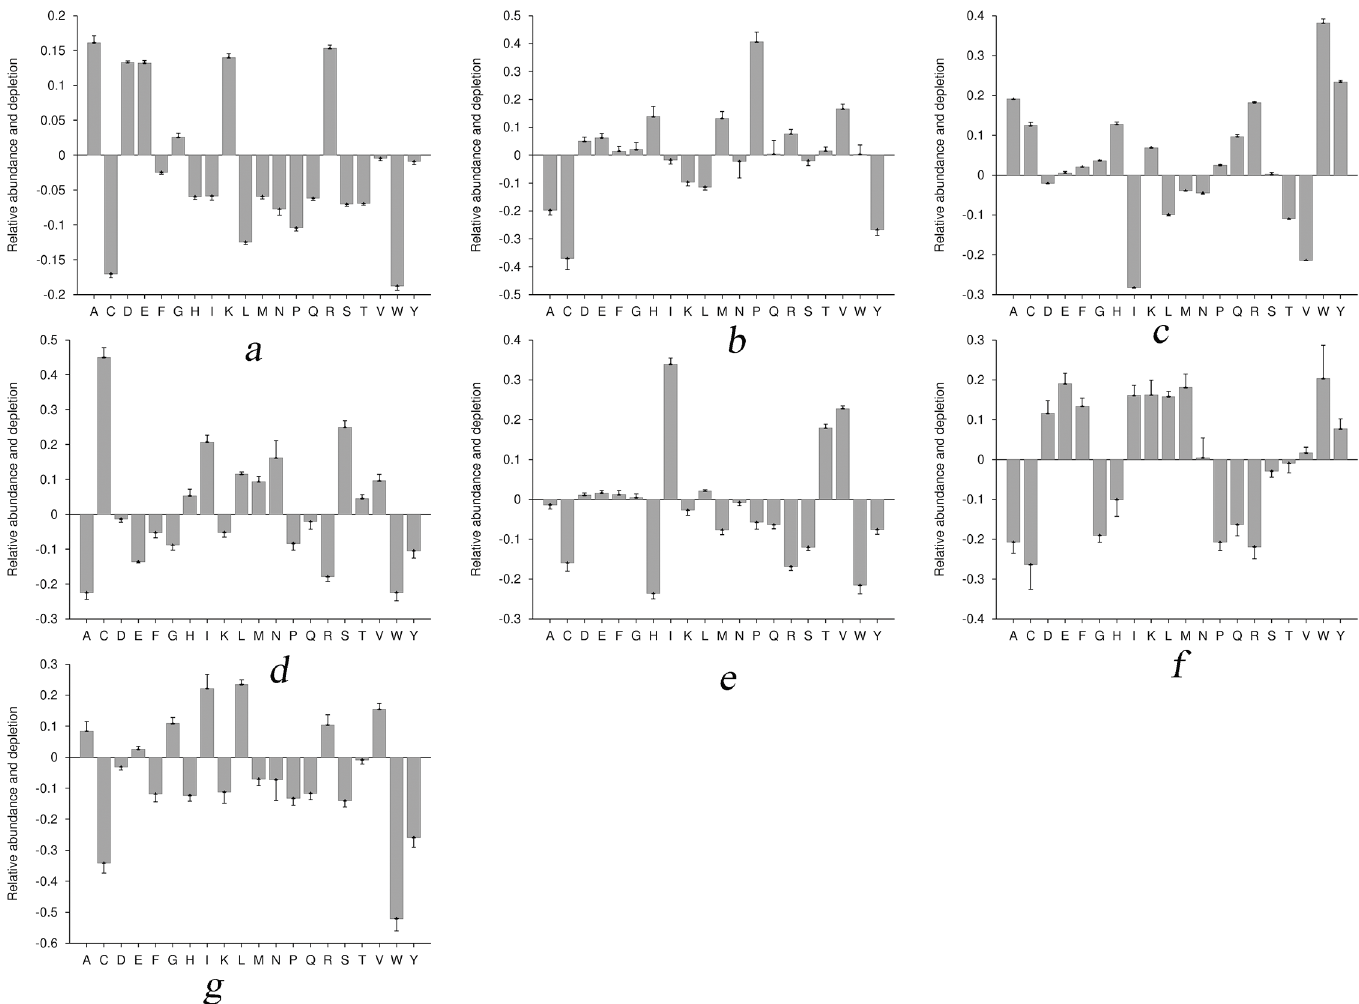
Fig 3. Relative enrichment and depletion of amino acids in HSP and their families with reference to non-HSP and other HSP families respectively. (3a) HSPs vs . Non-HSPs; (3b) HSP20 vs . remaining HSP family; (3c) HSP40 vs . remaining HSP family; (3d) HSP60 vs . remaining HSP family; (3e) HSP70 vs . remaining HSP family; (3f) HSP90 vs . remaining HSP family; (3g) HSP100 vs . remaining HSP